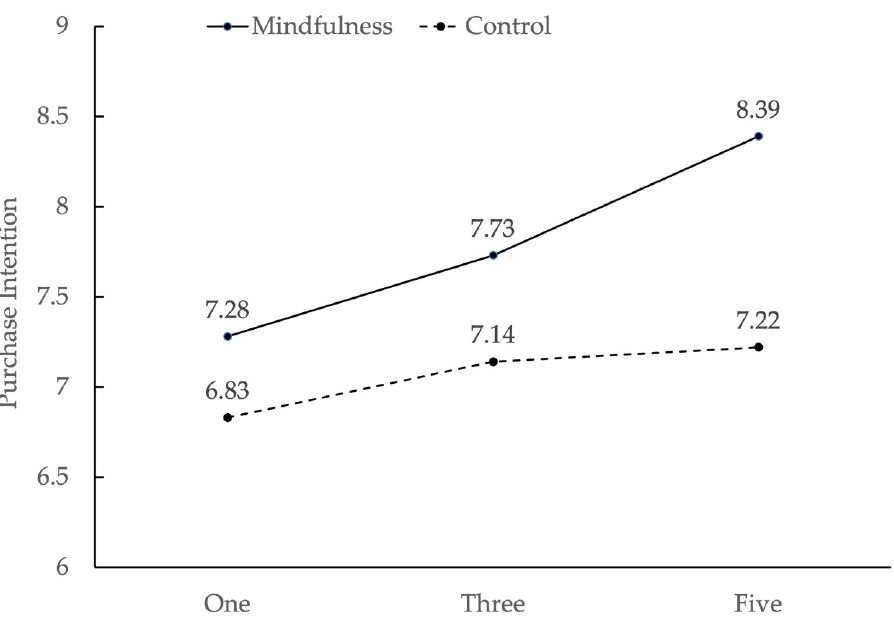
Figure 2. The interaction of purchase intentions between the number of sensory types and mindful- ness in Study 2.